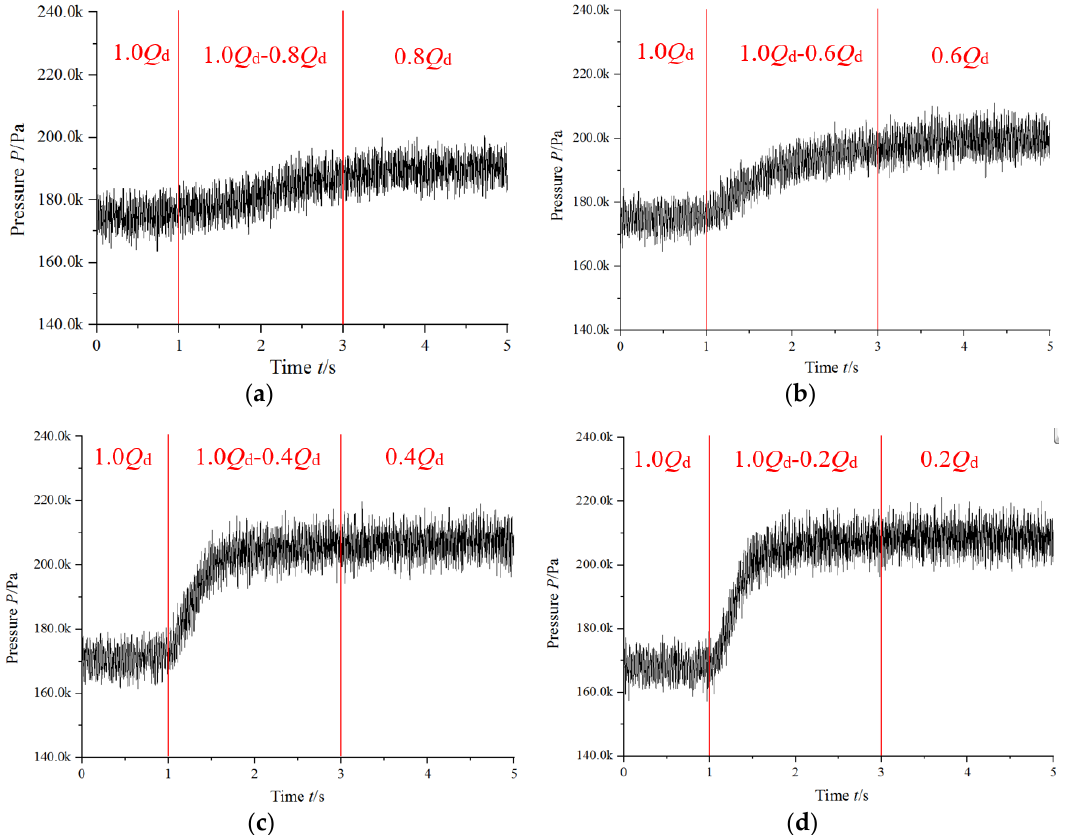
Figure 5. The time domain of pressure fluctuation at P2. ( a ) S1, ( b ) S2, ( c ) S3 and ( d ) S4.